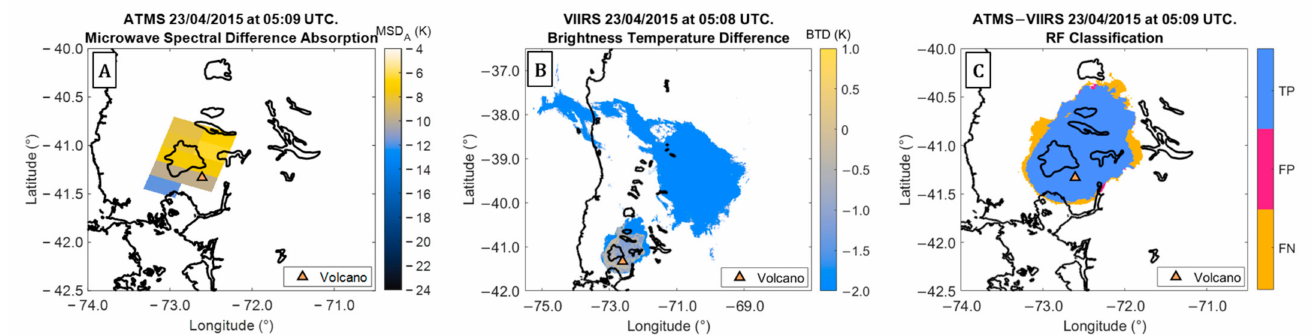
Figure 11. The Calbuco eruption on 23rd April 2015. ( A ) The volcanic cloud detected by using the MSD decision rule. ( B ) The volcanic cloud detected by the BTD decision rule. ( C ) The RF classification, where purple pixels are correctly classified ash pixels, magenta pixels are false alarms and orange pixels represent missed ash pixels.